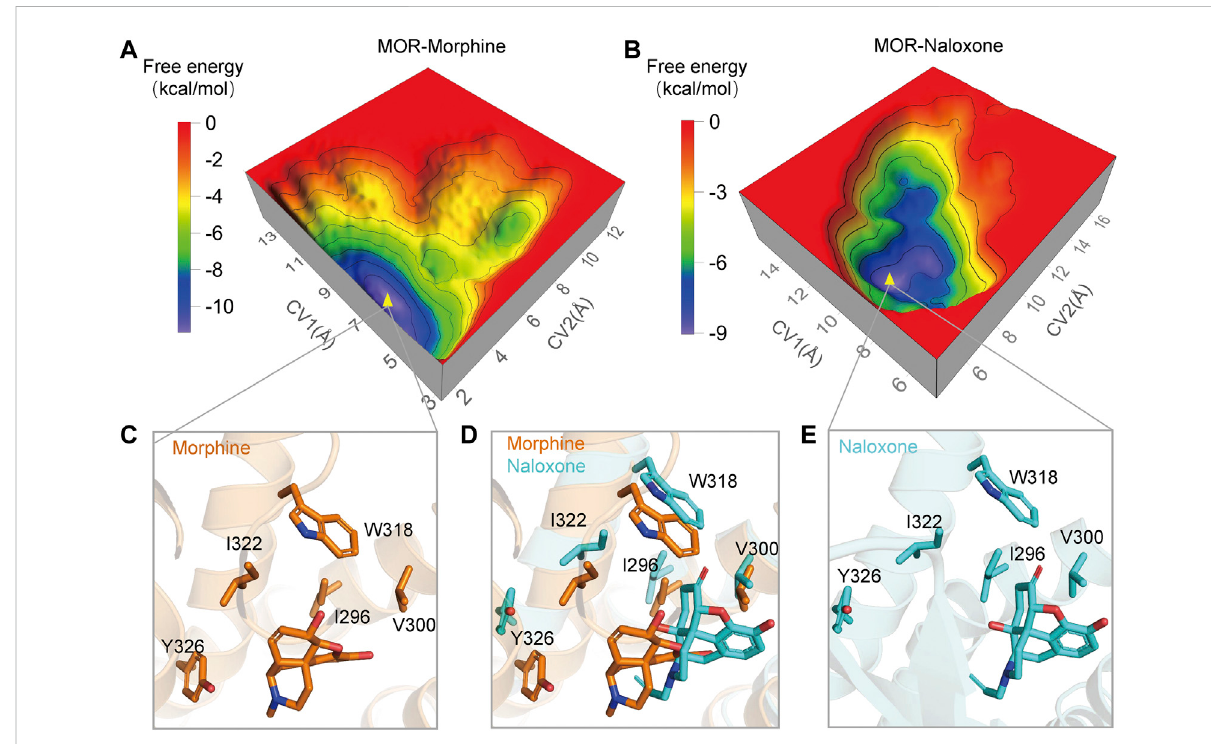
Three-dimensional (3D) free energy reconstruction and optimal binding conformation analysis of MOR/morphine, MOR/naloxone based on metadynamics (MetaD) simulations. (A,B) 3D-free energy reconstruction of the interaction between MOR/morphine and MOR/naloxone. (C , E) optimal conformation of morphine and naloxone binding to MOR during MetaD analysis. (D) optimal conformations of morphine and naloxone binding to MOR. Morphine binds more deeply in the MOR pocket compared to